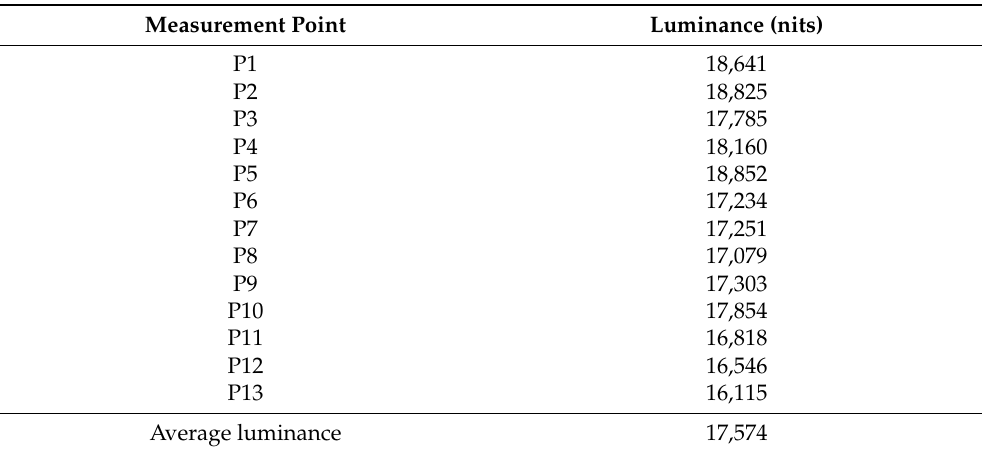
Table 3. Thirteen-point uniformity measurement of a 17 in extra-thin, large-area, high-luminance backlight module.